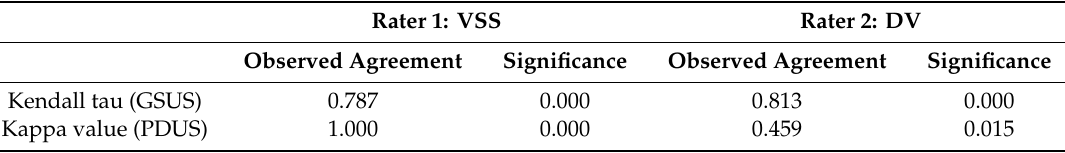
Table A1. Intra-reader reliability and assessment in 20 patients with rheumatoid